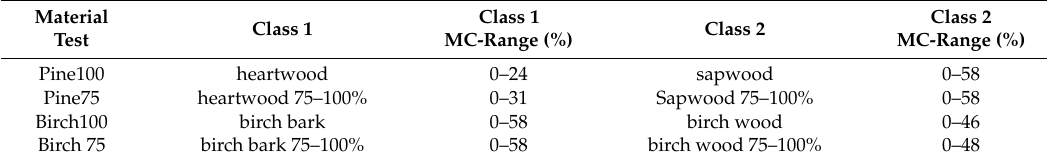
Table 2. Classification of heartwood content from pine chips and bark content from birch chips: material classes according to the content percentages and moisture content range of each class.